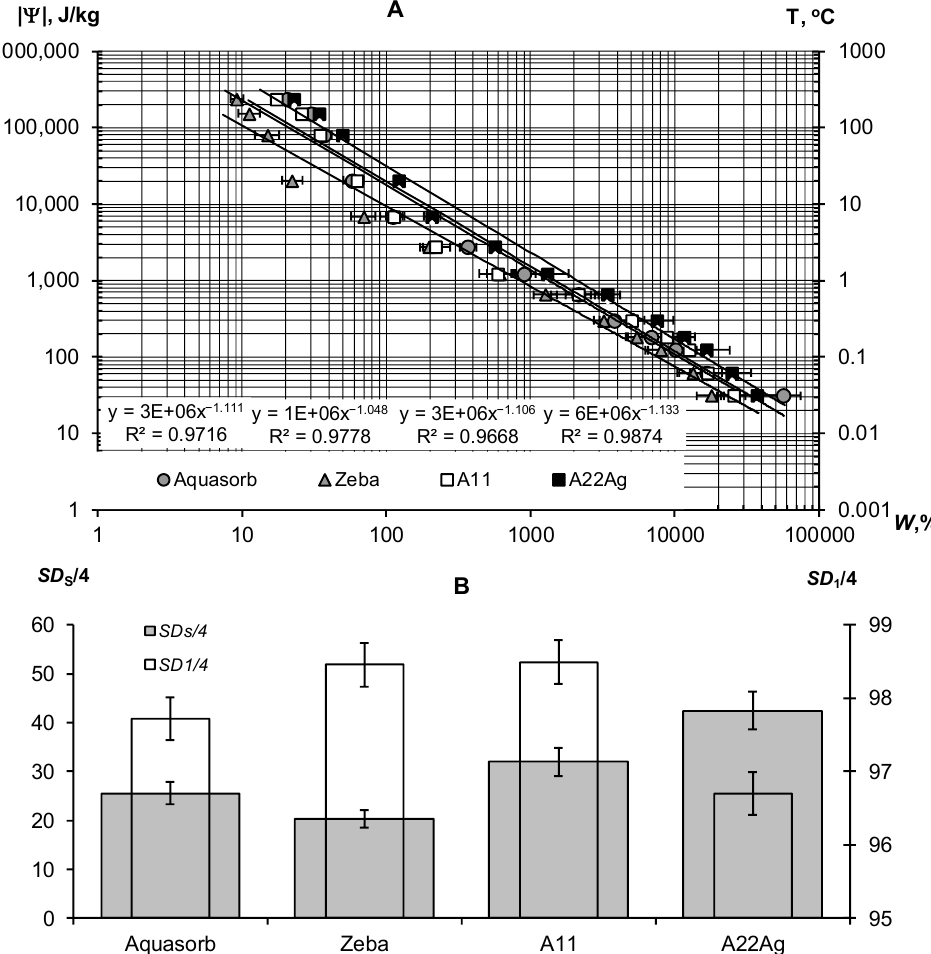
and ionic silver.